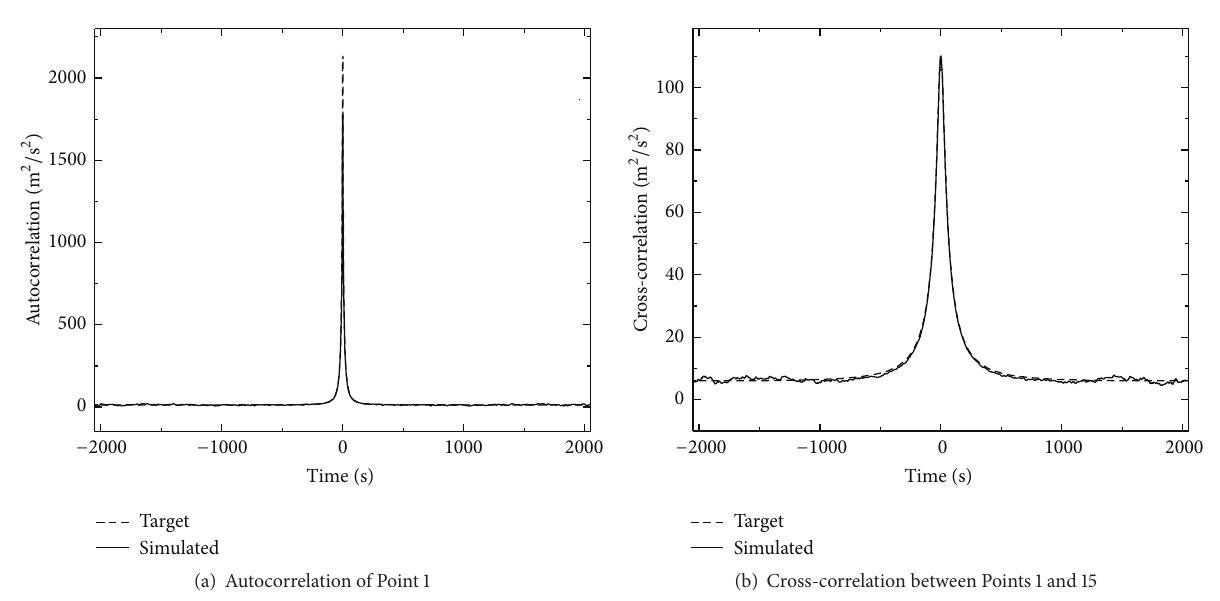
Figure 9: Correlation functions of longitudinal fluctuating wind velocities at bridge tower number